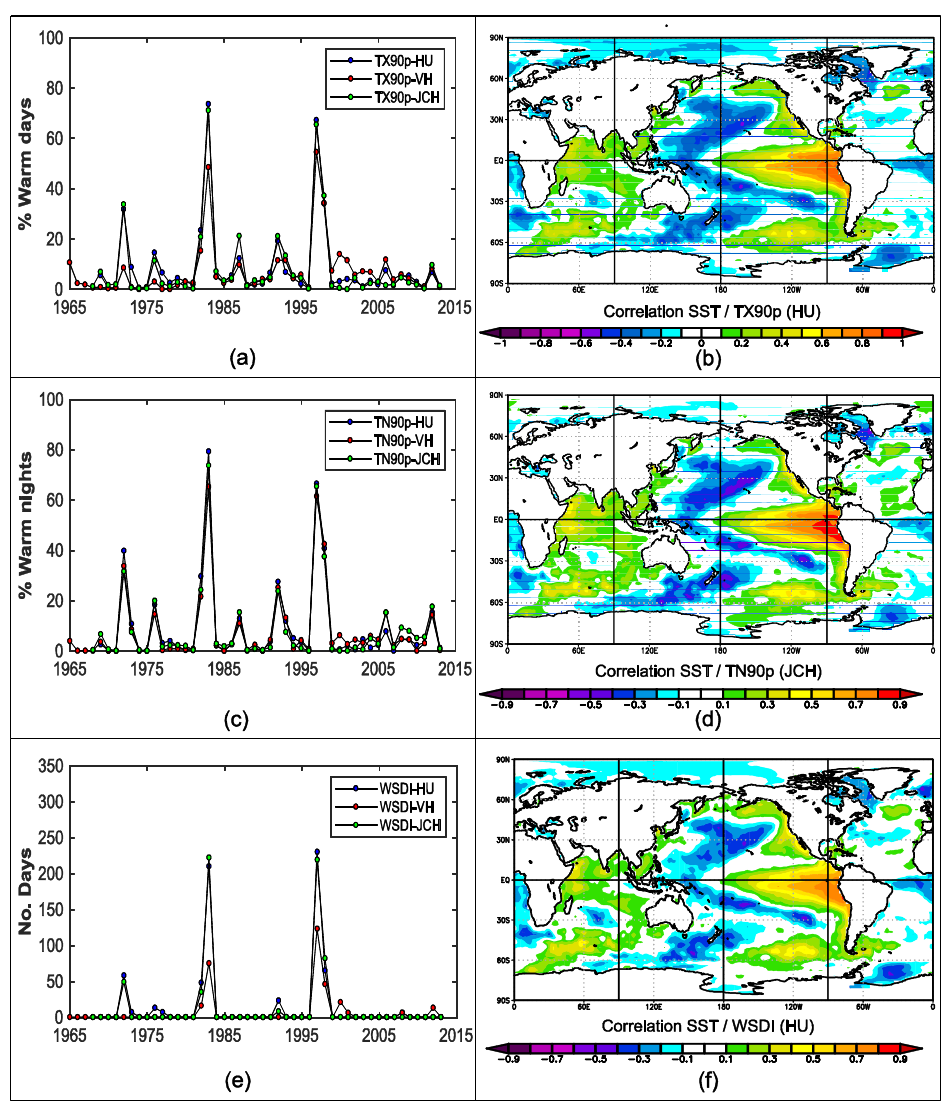
Figure 7. Variability and trends of extreme temperature indices: ( a ) TX90p, ( c ) TN90p, and ( e ) WSDI, these indices show no trend. Spatial field of annual correlations between Sea Surface Temperature (SST) and ( b ) TX90p, ( d ) TN90p, and ( f ) WSDI for the period 1965 – 2013. HU, VH, and JCH station. NCEP/NCAR Reanalysis. Source: NOAA/ESRL Physical Sciences Laboratory. The influence of El Niño/La Niña events on the duration of heat waves (WSDI) and